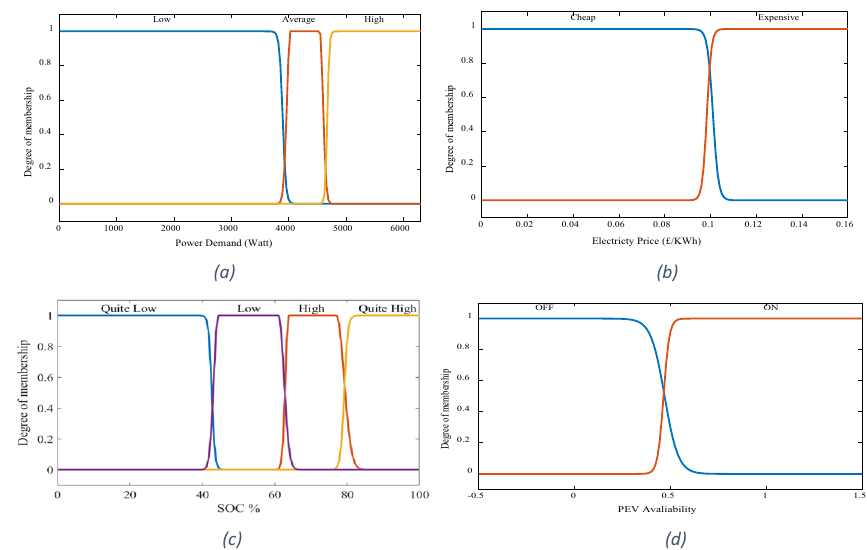
Fig. 4 PEV management fuzzy sets of the input variables a power demand, b electricity price, c SOC%, d PEV